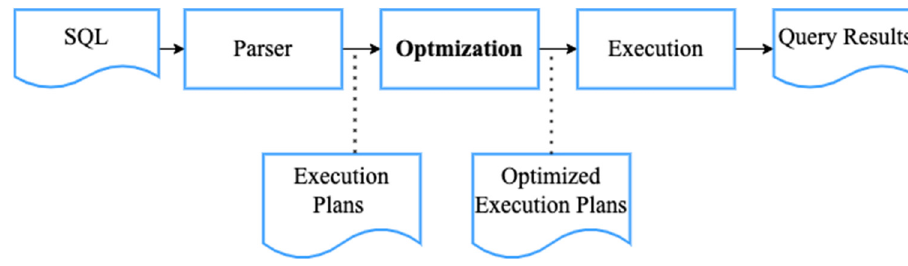
Figure 1. The flowchart of an SQL query process.